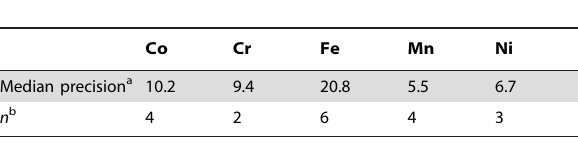
Table 2. Precision of analysis quantified from sample replicates subjected to the in vitro FOREhST